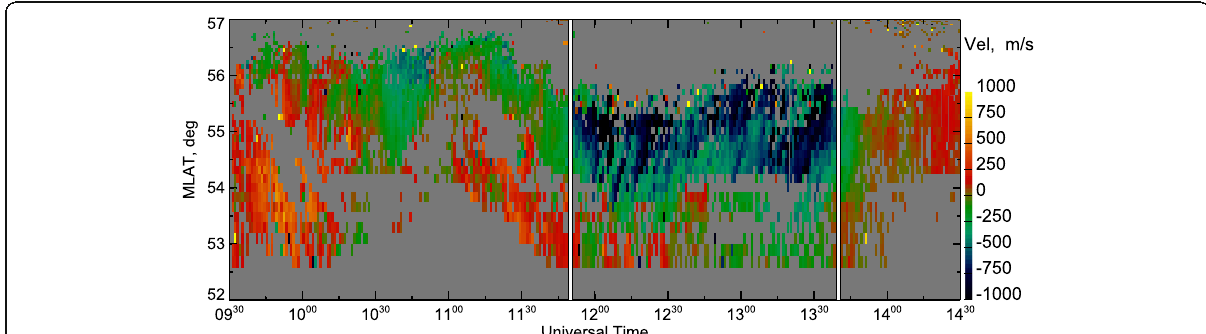
Fig. 10 CVW velocity in beam 4 on 17 March 2013, 0930 – 1430 UT. The green cells refer to the SAPS region. The two vertical white lines mark the period of narrow and intense SAID feature. The period of strong SAPS Wavy Structure (SAPSWS) activity is near 1215 UT. Reproduced from Fig. 2a of Makarevich and Bristow